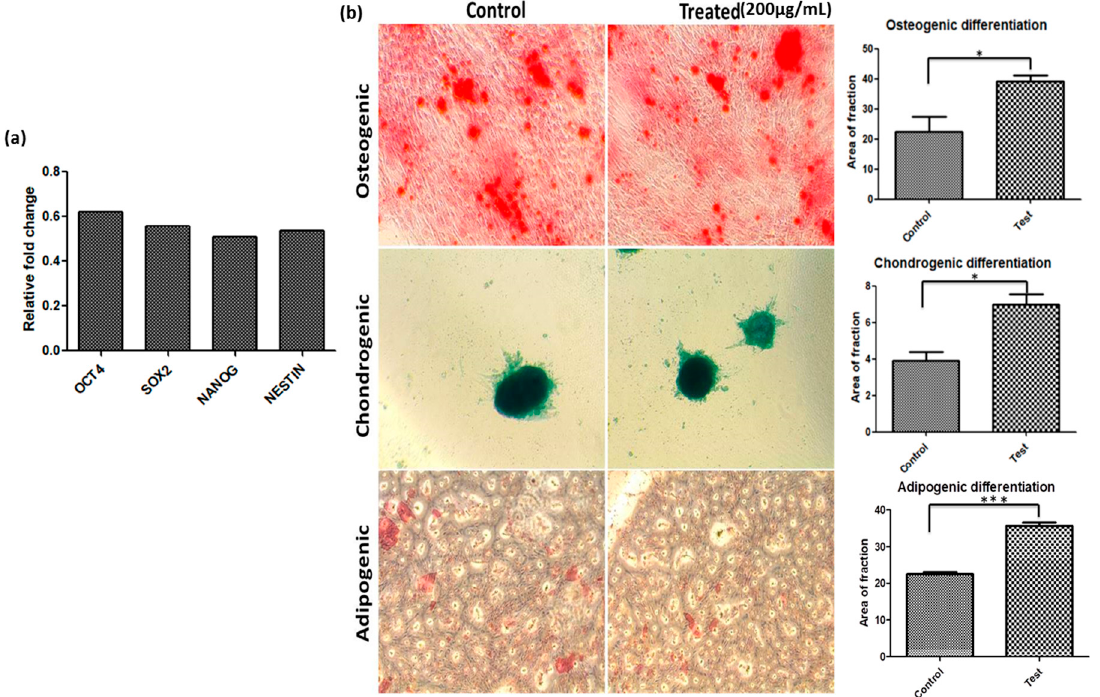
Figure 7. Impact of nanosheet on stemness and tri-lineage differentiation potential of WJ-MSCs. ( a ) Expression of stemness marker, ( b ) Phase contrast microscopic images and gene expression analysis showing the enhanced tri-lineage differential potential of WJ-MSCs with the nanosheet. (* p-value < 0.05; *** p-value < 0.001).